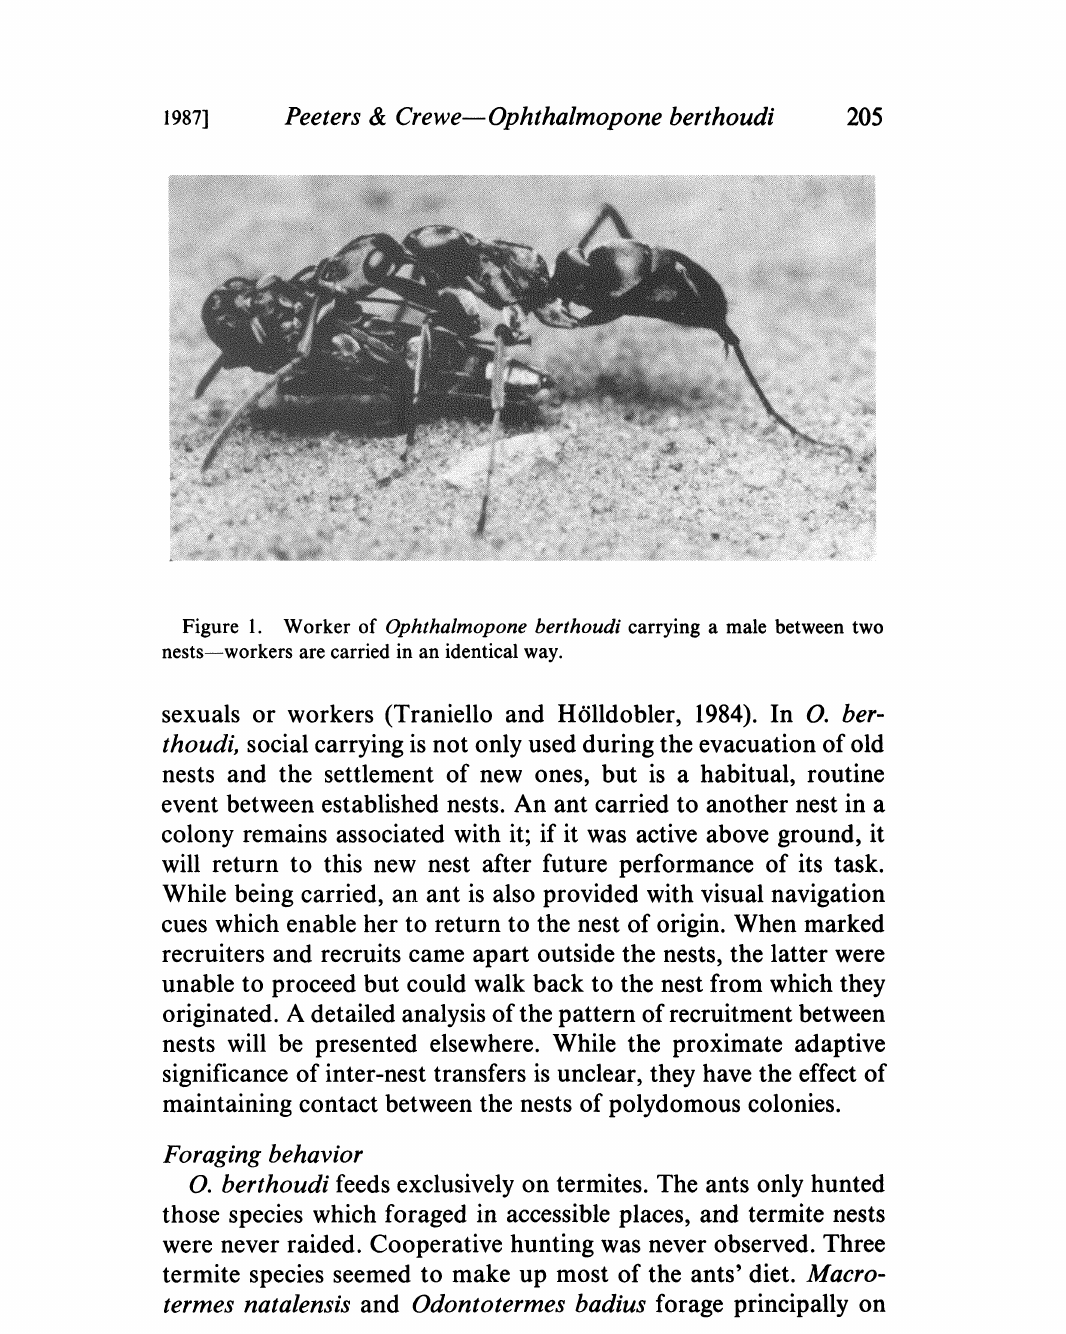
Figure 1. Worker of Ophthalmopone berthoudi carrying a male between two nests--workers are carried in an identical